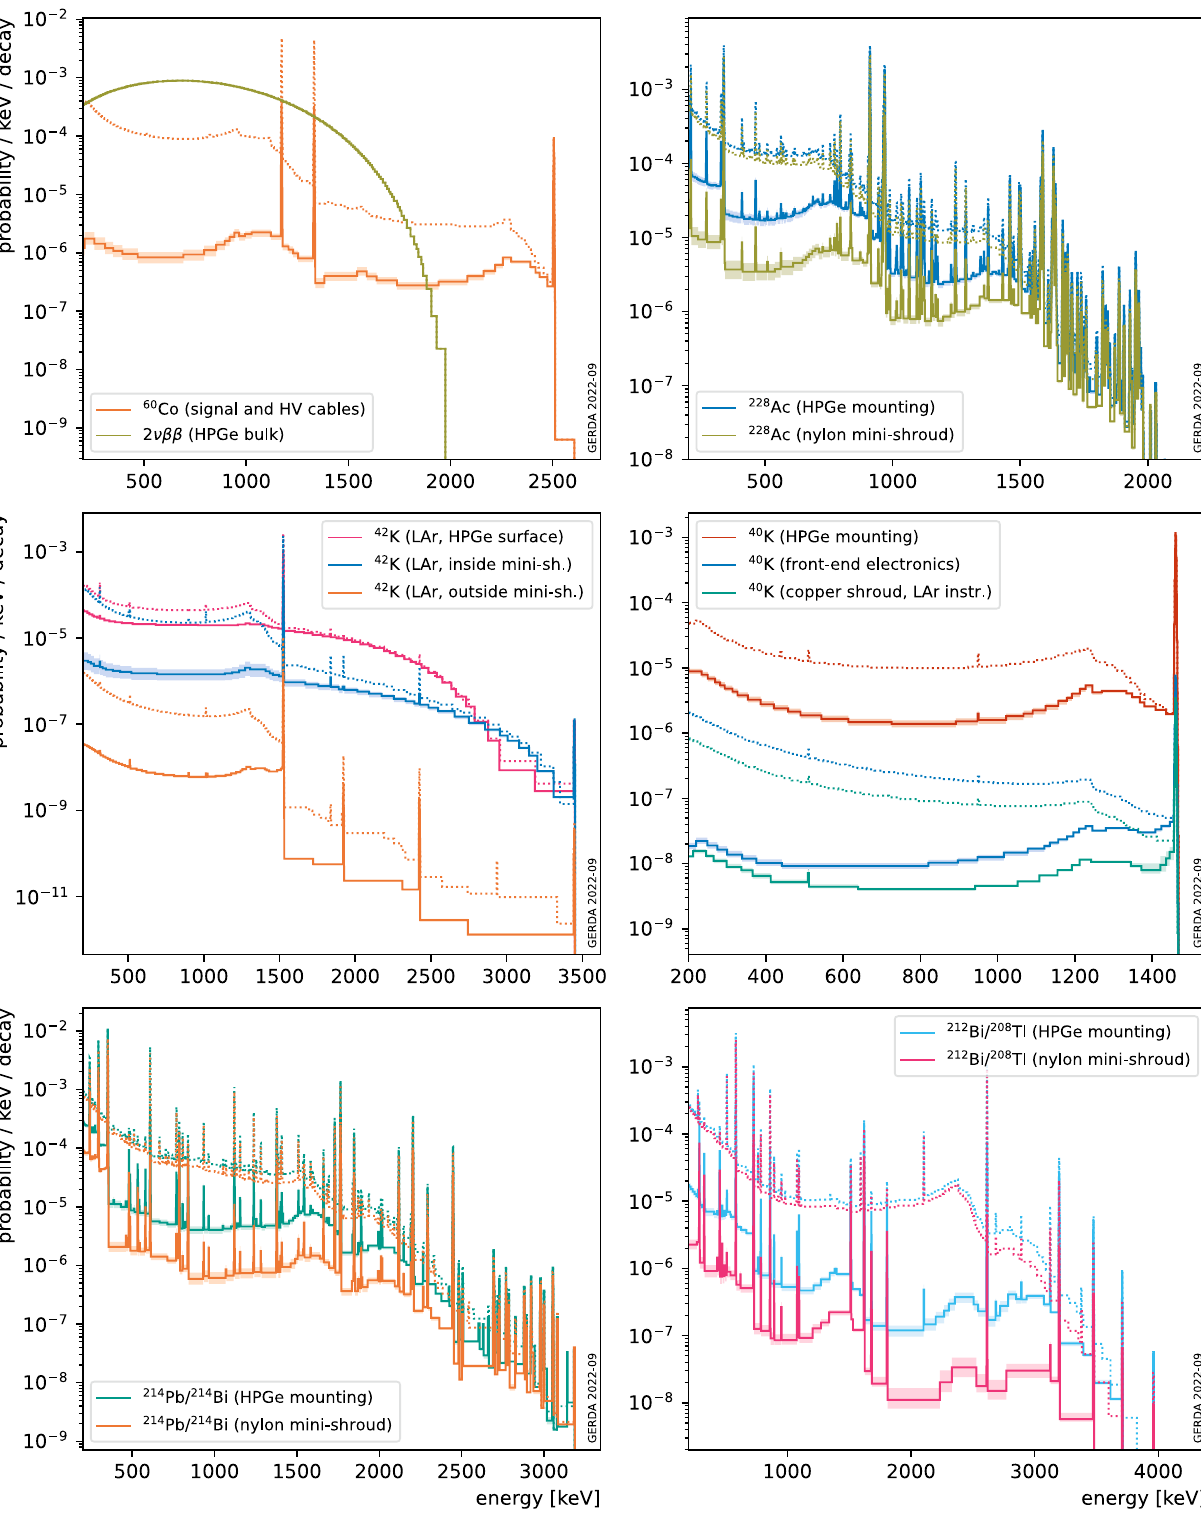
bands of lighter color. pdfS before the cut [28] (dotted lines) are over- laidforcomparison.Thereaderisreferredto[28,Figure1]foradetailed documentation of the simulated setup. A variable binning is adopted for visualization